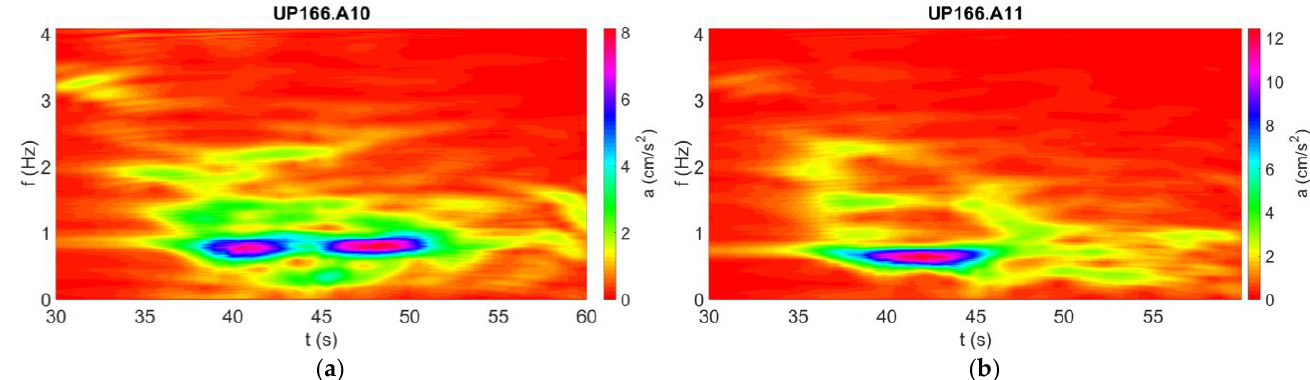
Figure 8. Time-frequency analysis for ( a ) A10 and ( b ) A11.